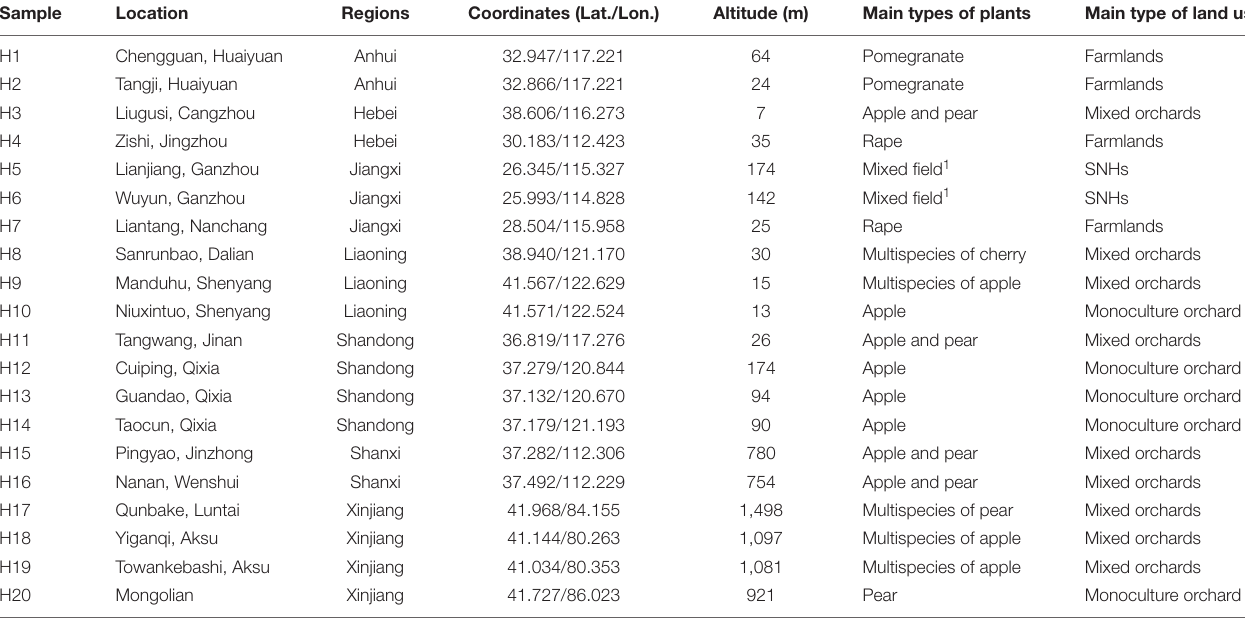
TABLE 1 | Geographic information of pollen plants in 20 experimental plots. Sample Location Regions Coordinates (Lat./Lon.) Altitude (m)